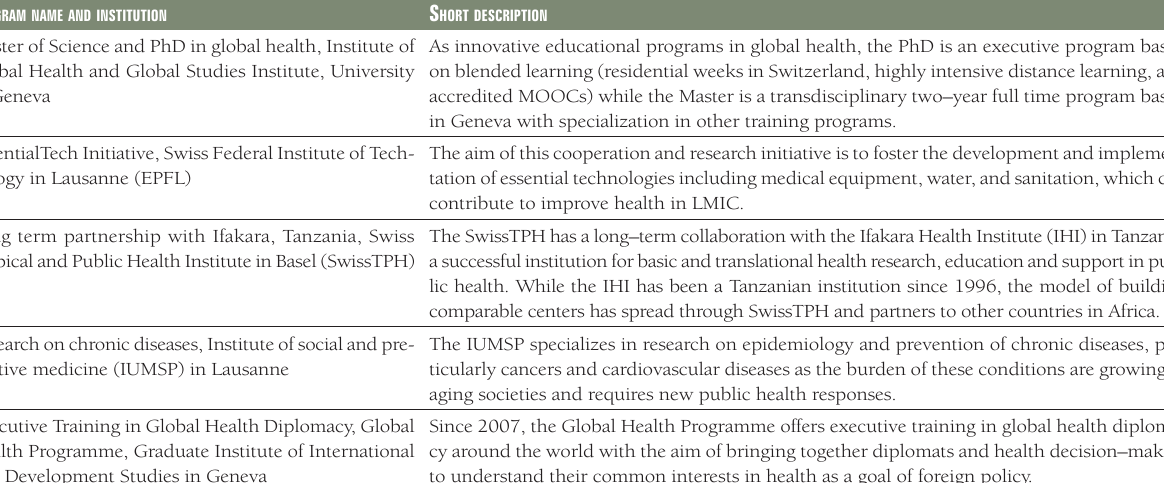
Table 1. Examples of programs in global health based at five Swiss academic institutions